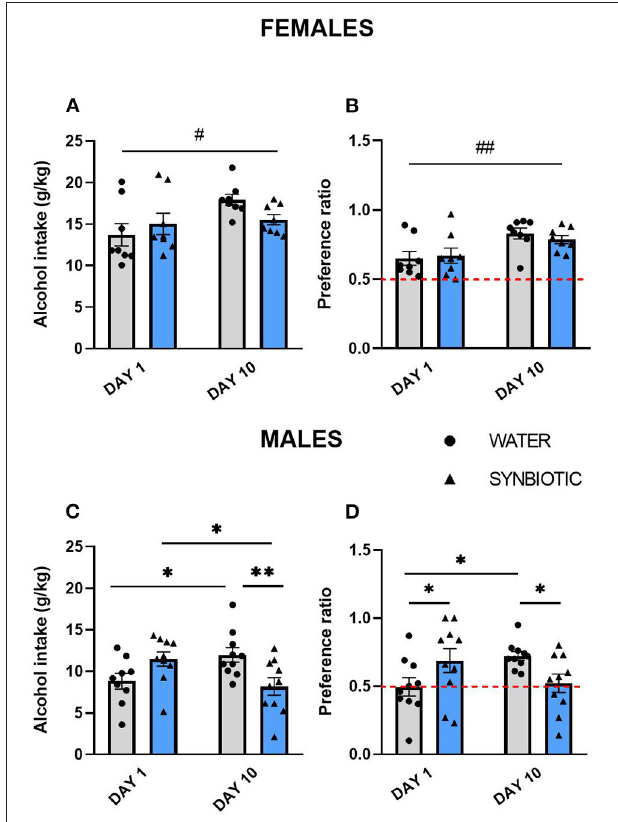
FIGURE 2 | Alcohol intake and preference during intermittent access to alcohol (15% ethanol solution in water) in female and male mice treated with water (gray bars and round symbols), or synbiotic (blue bars, triangular symbols). (A) Female mice treated with water drank more alcohol (g/kg) during 24h on day 10 with respect to day 1 (main effect of day, p < 0.05), while mice in the synbiotic group drank similar amounts of alcohol on both days. (B) Preference for alcohol in females increased on day 10 vs. 1 in both the water and the synbiotic groups (main effect of day, p < 0.01). (C) Male mice